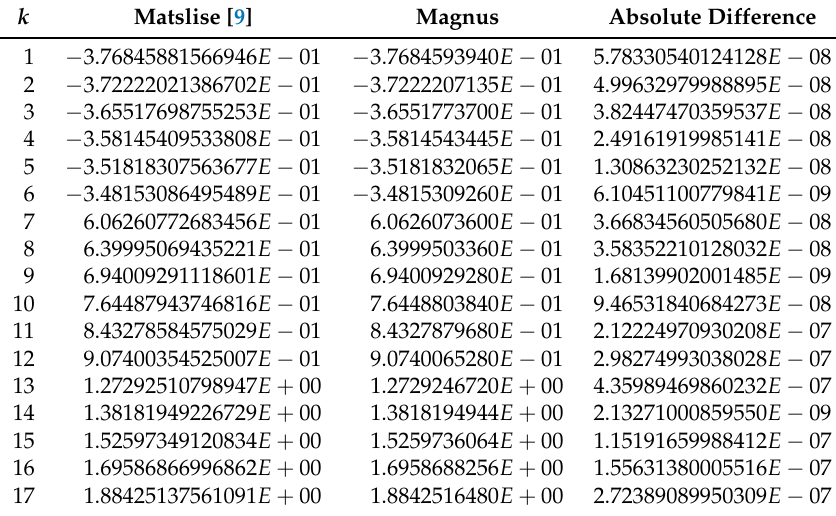
Table 3. The first 17 eigenvalues and errors for the version of the Mathieu equation (Equation (31)) using Matslise and Magnus method.